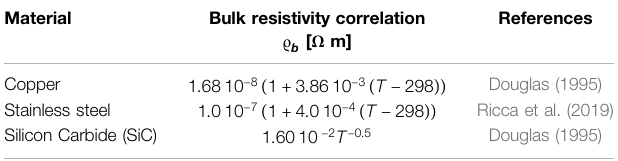
TABLE 2 | Electrical resistivity of considered materials. Material